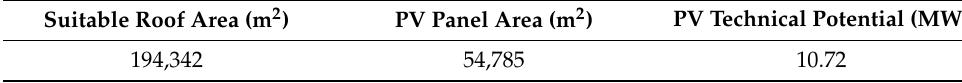
Table 2. Pantelleria PV technical potential on roofs.